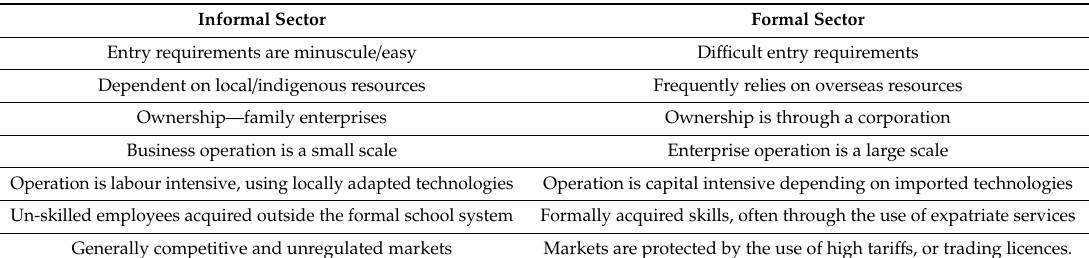
Table 3. Di ff erences between the informal and formal economies [31,32].